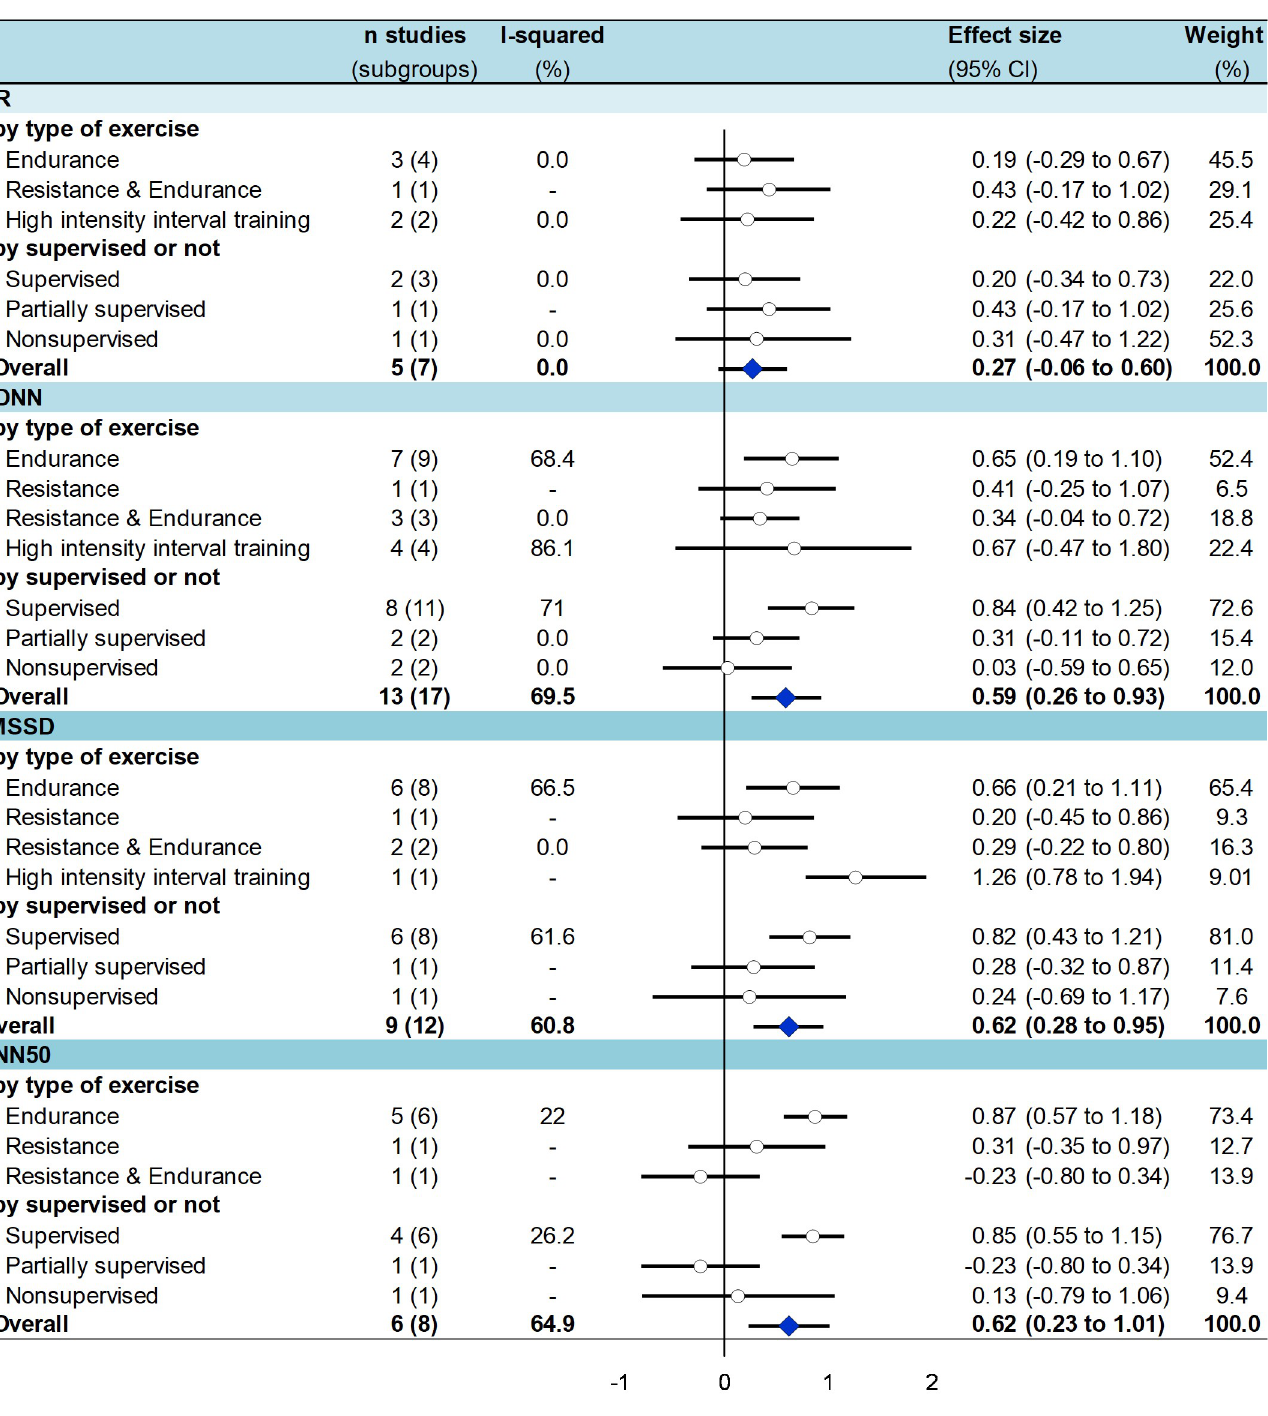
Fig 2. Summary of meta-analysis on the effect of exercise training on time domain parameters of HRV in T2DM patients—stratified by type of exercise and type of supervision.